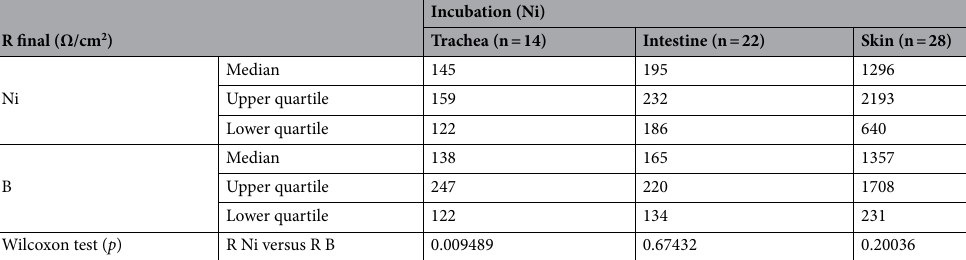
Table 3. Transepithelial resistance (R) of the trachea, intestine and skin measured in stationary conditions at the end of experiments and treated by the solution of nickel chloride (0.1 mM) and bumetanide (0.1 mM). The values of medians and lower and upper quartiles are given. Abbreviations: B—bumetanide (0.1 mM) solution, Ni—nickel chloride (0.1 mM) and bumetanide (0.1 mM) solution, R final—resistance measured after 75 min (Ω/cm 2 ), p <